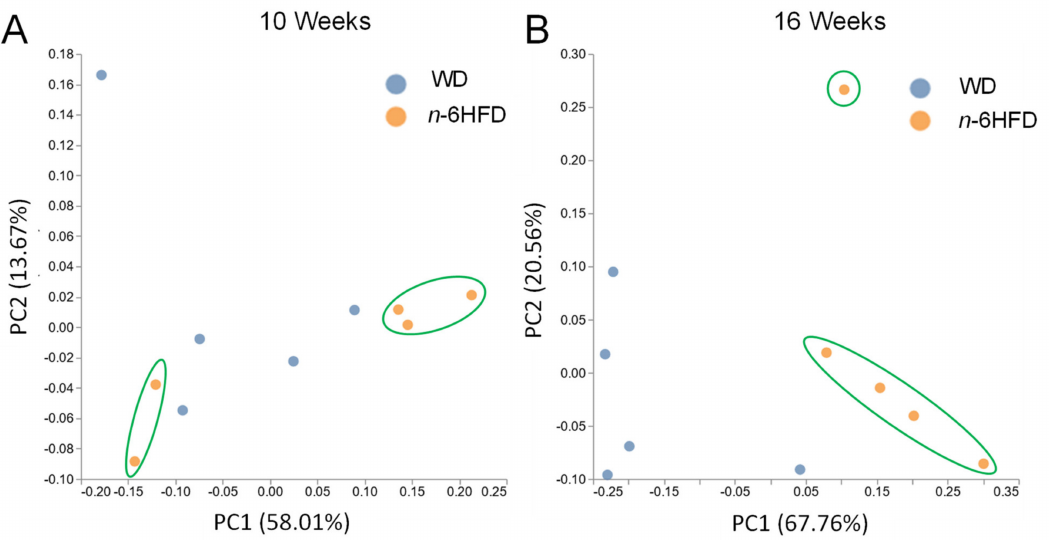
Figure 7. Principal component analysis of the cecal microbiota from WD and n -6HFD-fed C57BL/J6 male mice. Diagram axes depict the percent of variance explained by principal component 1 (PC1) and PC2. Plots are based on bacterial relative abundance profiles for each mouse at ( A ) 10 weeks and ( B ) 16 weeks of age. Mice fed n -6HFD mice are circled (green) to highlight clustering separation from WD-fed mice.